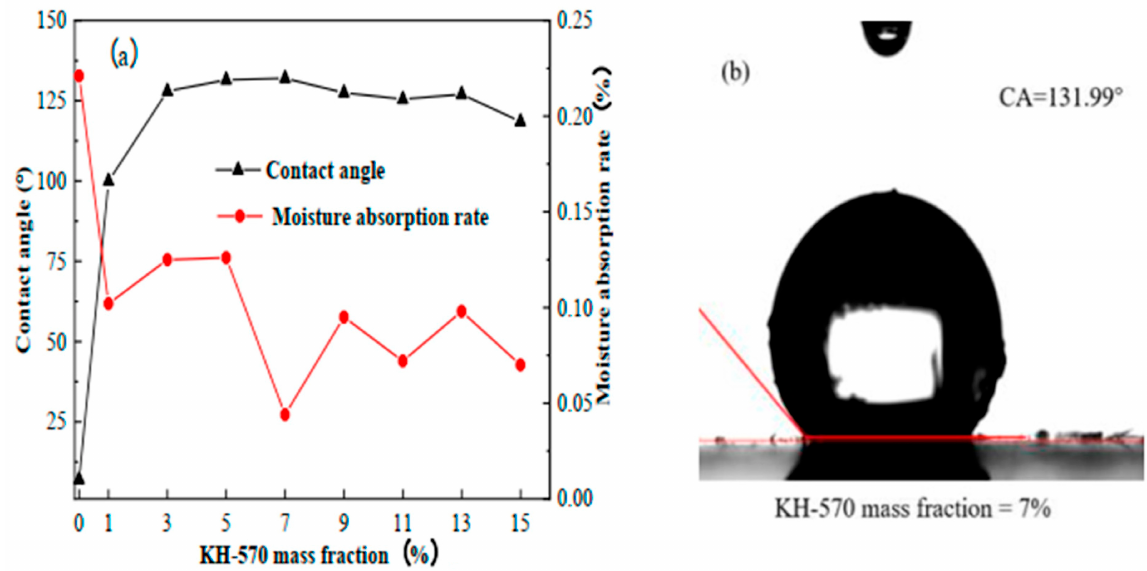
Figure 3. ( a ) Contact angles and moisture absorption rates of biochar modified by KH-570, and ( b ) contact angle of modified biochar when KH-570 mass fraction was 7%.